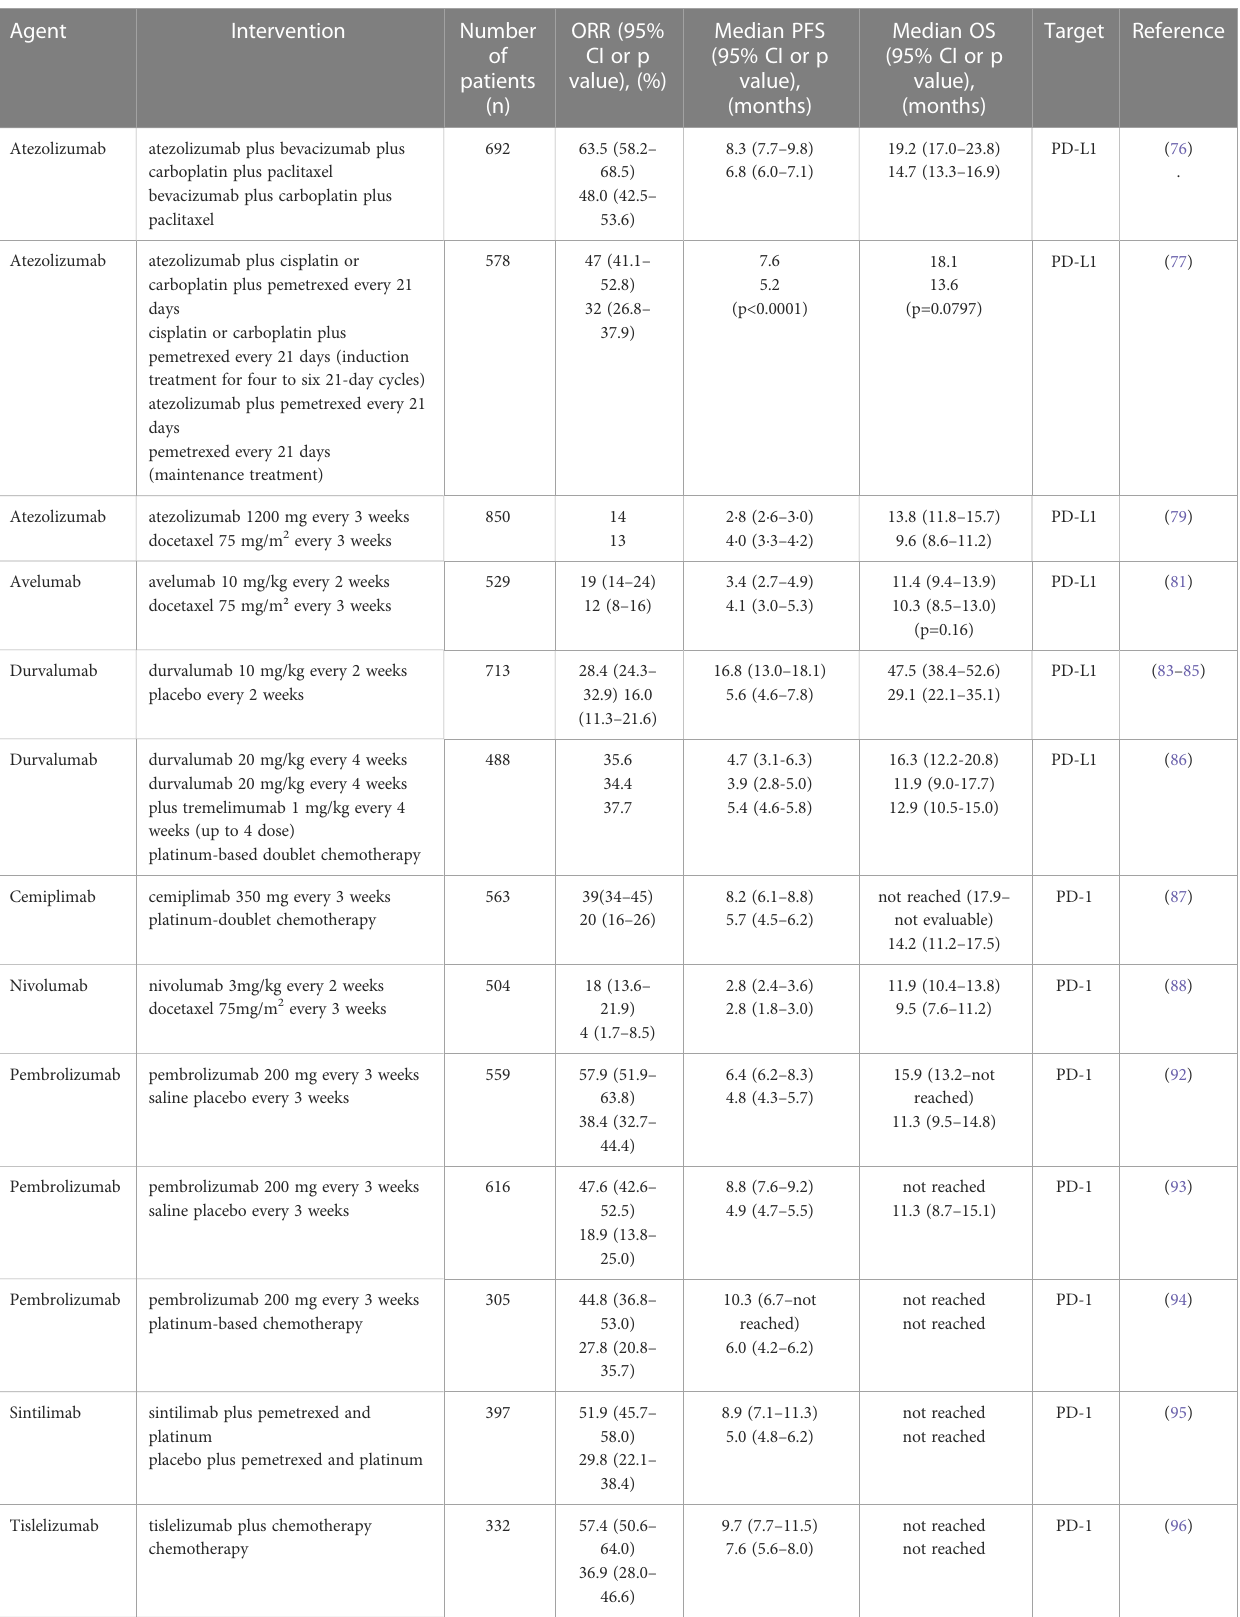
TABLE 2 Completed phase 3 NSCLC clinical trials of PD-1/PD-L1 and CTLA-4-targeted monoclonal antibodies in recent 5